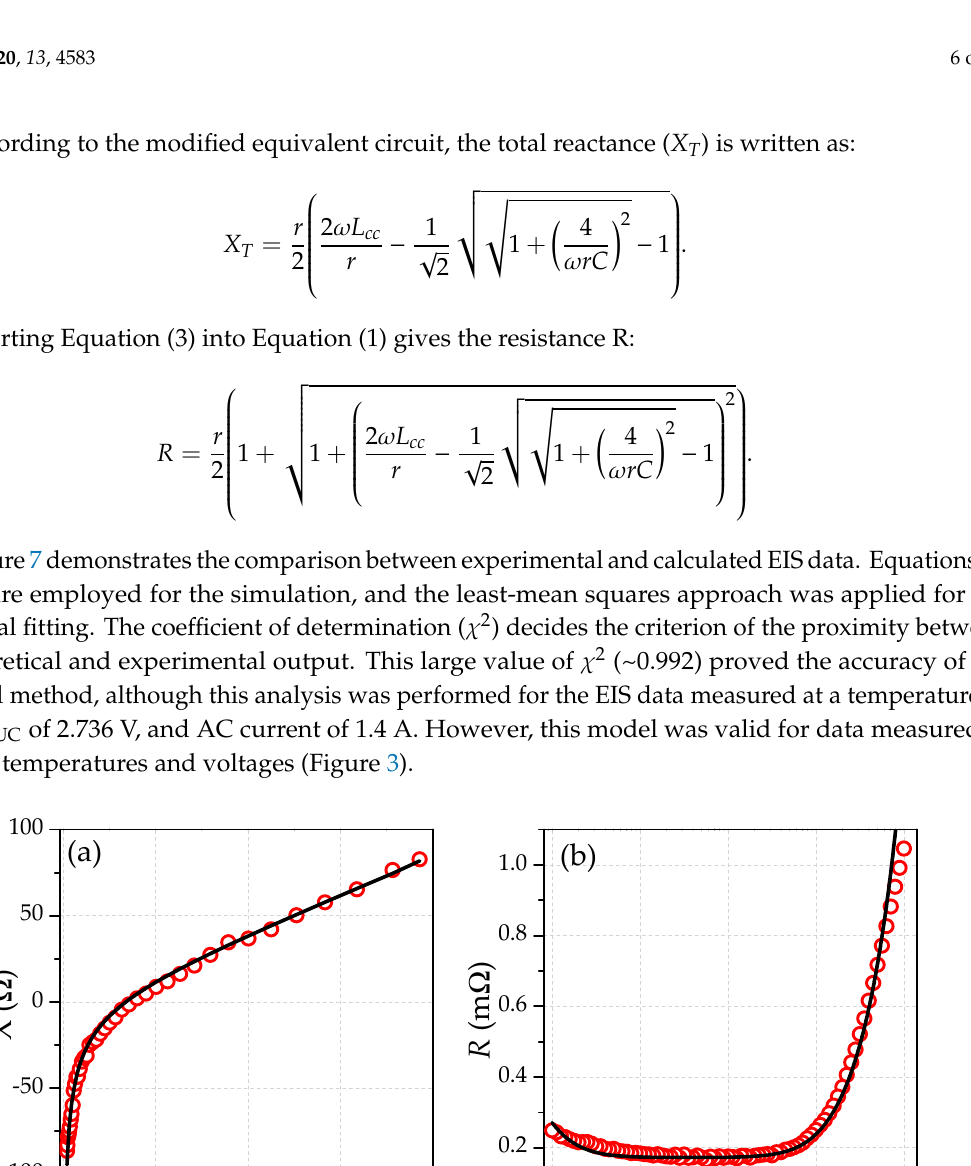
Figure 6. Modified equivalent circuit of the ultracapacitor. The component, L cc, represents the inductivity of connection wires.